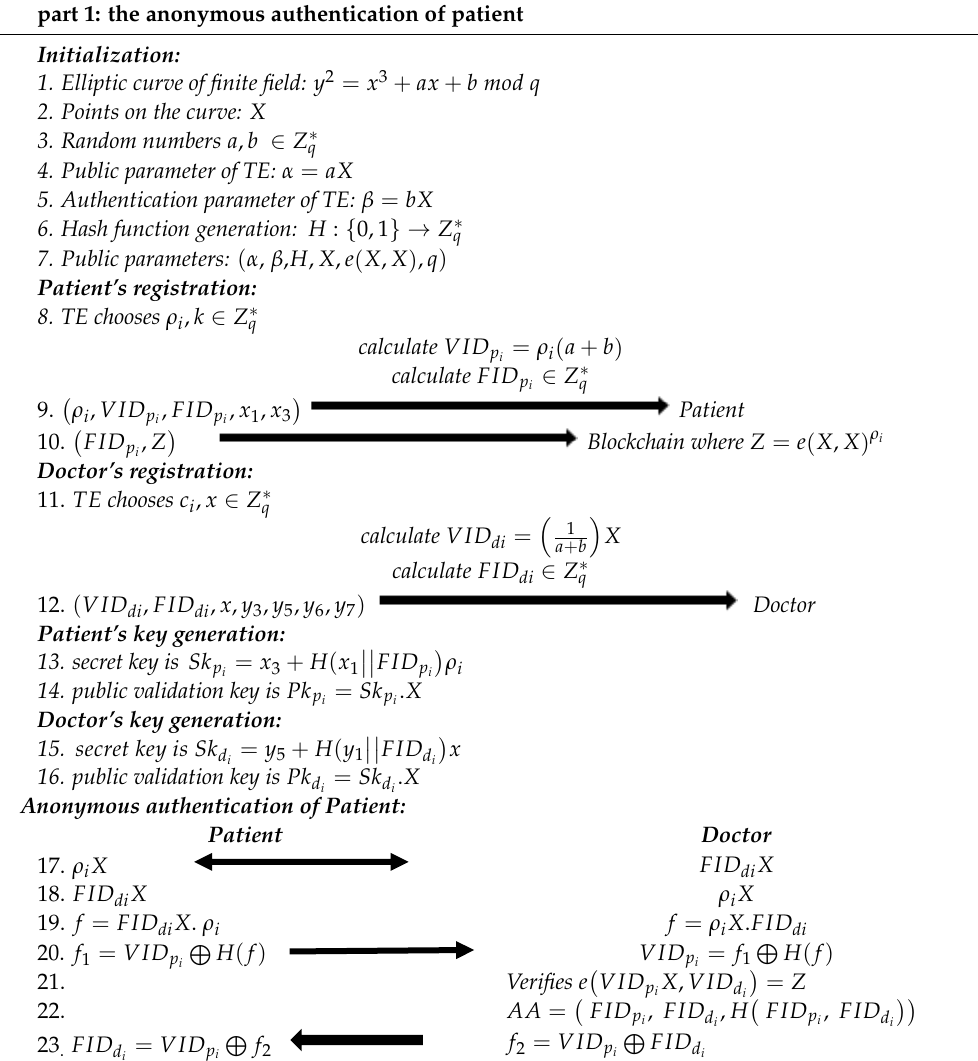
Algorithm 1: Flow diagram of registration, key generation and authentication of patient.